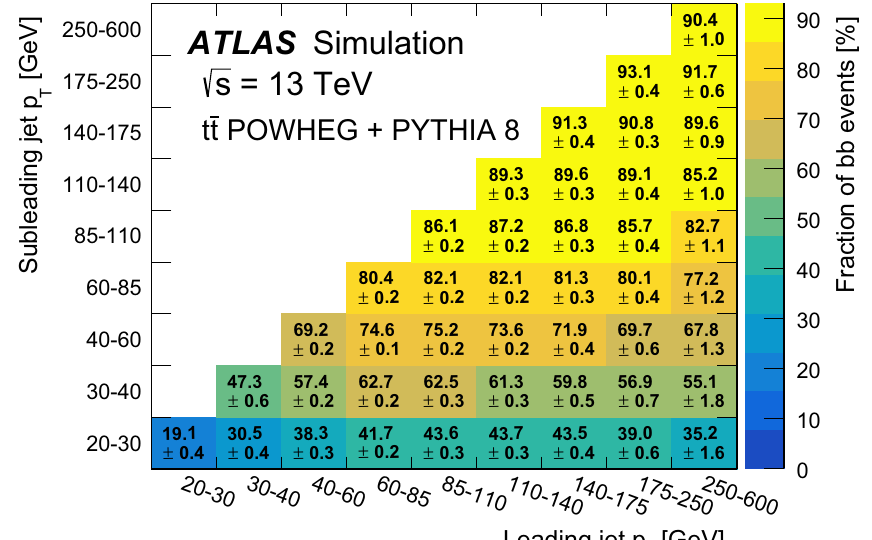
Fig. 7 Fraction of bb events in the signal region as predicted by the simulation as a function of the leading and subleading jet p T . Uncertainties are statistical